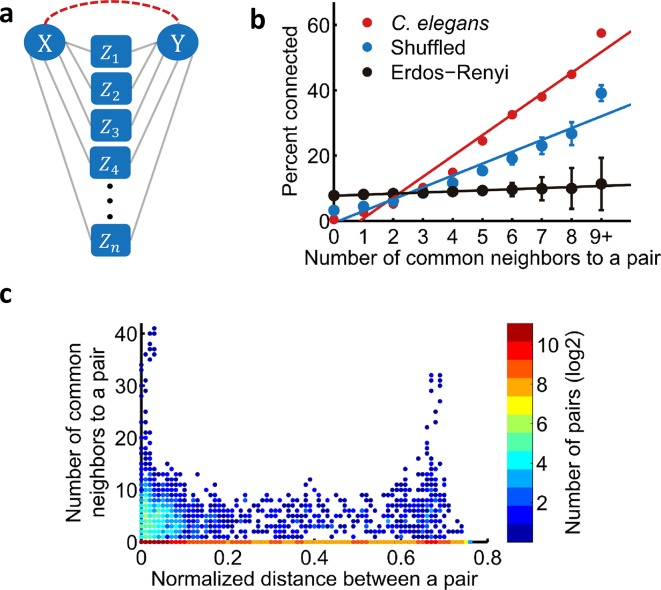
The common neighbor rule is an emerging property in the C. elegans neural network.(a) A set of common neighbors. According to the common neighbor rule, the more common neighbors (Z’s) a pair of nodes (X, Y) shares, the more likely for the pair to be connected (dashed, red). (b) The common neighbor rule is significantly more prominent in the C. elegans neural network (red) than in various random networks. Blue: random networks generated with the same degree distribution as the C. elegans neural network; Black: Erdős–Rényi random networks. Each random network has been fitted to a linear function, and the slopes were compared to the C. elegans slope (blue: R2 = 0.96, p<10–10; black: R2 = 0.94, p<10–10; z-test). Error bars indicate standard deviation of 1,000 random networks. (c) The number of connected common neighbors to a pair is not biased by the physical distance between the pair of neurons (r = -0.13, p ≈ 1; One tailed student's t-test for Pearson correlation coefficient). Note the log scale of the color bar indicating that a large fraction of the connected pairs have zero common neighbors. The two peaks at short and long inter-somatic distances are due to the major head and tail hub neurons.